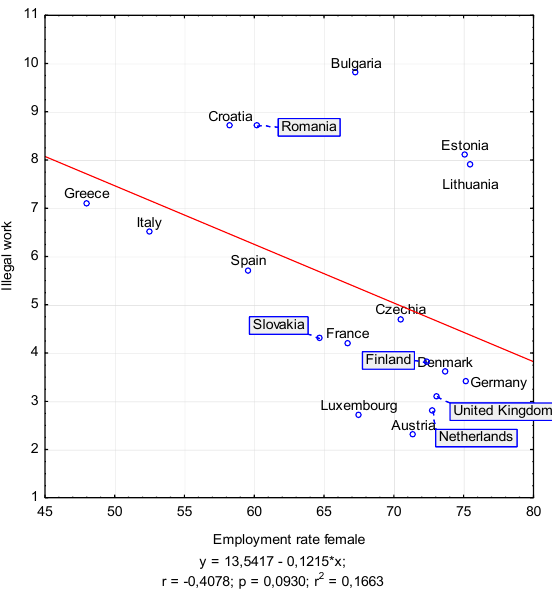
Figure 4. Regression model for illegal work in terms of employment rate for women in the selected European Union